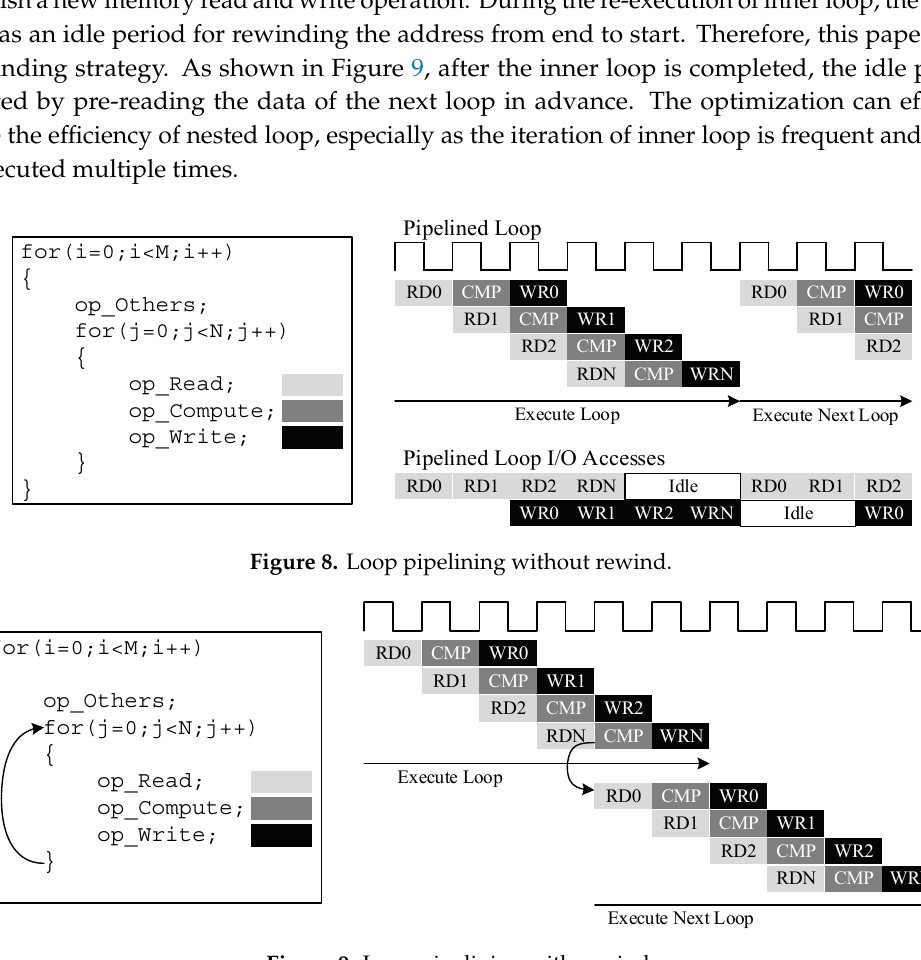
Figure 9. Loop pipelining with rewind.